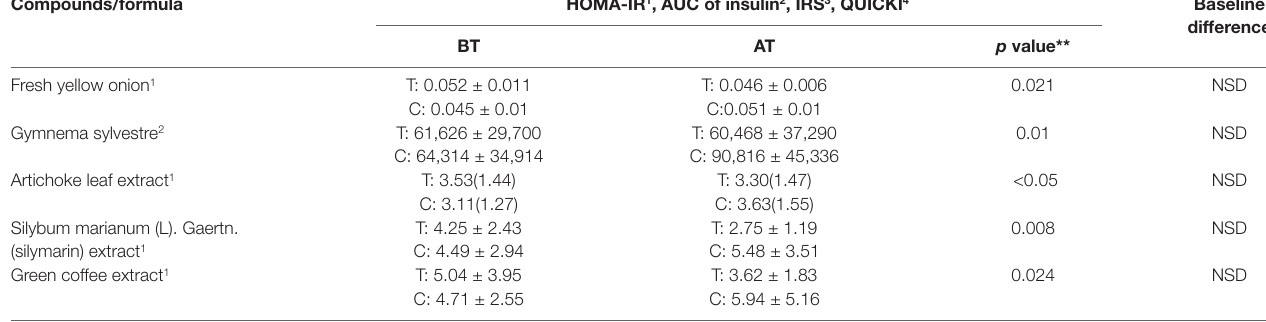
( Table 4 ), natural product ( Table 5 ), and herbal